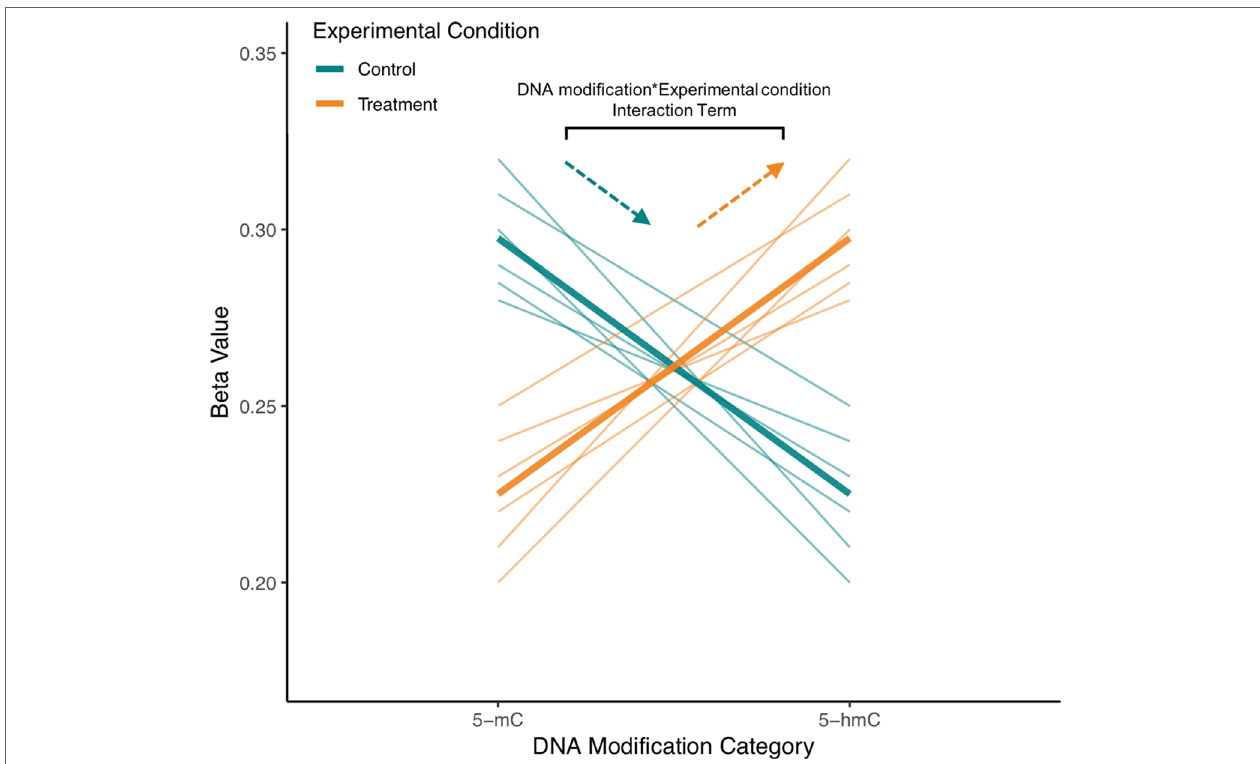
FIGURE 5 | Visualization of interaction term from example repeated measures model for single CpG site from mock BS/oxBS data. In the proposed ME model treating 5-mC and 5-hmC as repeated measures, a random effect for ID will account for the correlation between 5-mC and 5-hmC at a CpG site. Meanwhile, a “DNA modification*Experimental Condition” interaction term will be used to determine whether 5-mC and 5-hmC differ in their response to experimental condition. In the visualized mock data, brain samples from exposed animals have an increased slope compared with those from control animals, indicating that experimental treatment is shifting the CpG site toward 5-hmC in the brain. As indicated in the figure, this difference in slope is modeled by the “DNA modification*Experimental Condition” ( β 1 x 1 x 2 ) interaction term. The proposed statistical approach can pick up regions where trajectories of 5-mC/5-hmC change while also accounting for the fact that 5-mC and 5-hmC are dependent measures. Furthermore, fixed effect terms for 5-hmC and 5-mC could also be included to model the response of either 5-mC or 5-hmC to experimental